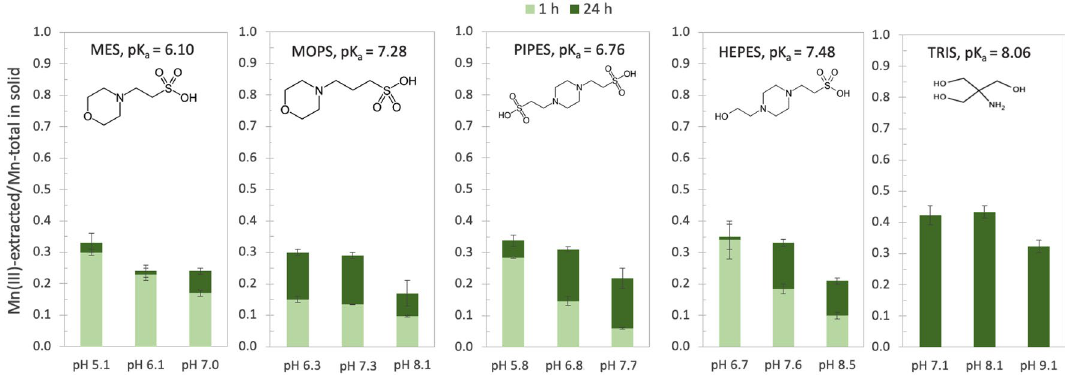
Figure 1. Generation of Mn(III) in δ-MnO 2 (t = 0: AMON = 4.0) after reaction with 10 mM MES-, MOPS-, PIPES-, HEPES-, and TRIS-buffer as a function of pH (± 1 pH unit from pK a ) after 1 h (light green) and 24 h (dark green). Pyrophosphate extractions were used to quantify Mn(III) generated upon reaction with all buffers except TRIS. The Mn(III) content of TRIS-reacted δ-MnO 2 was estimated from AMON values; no 1 h data are available for experiments with TRIS buffer. Error bars represent standard deviation of triplicates for all except TRIS where n = 2. The pK a values indicated are for 25